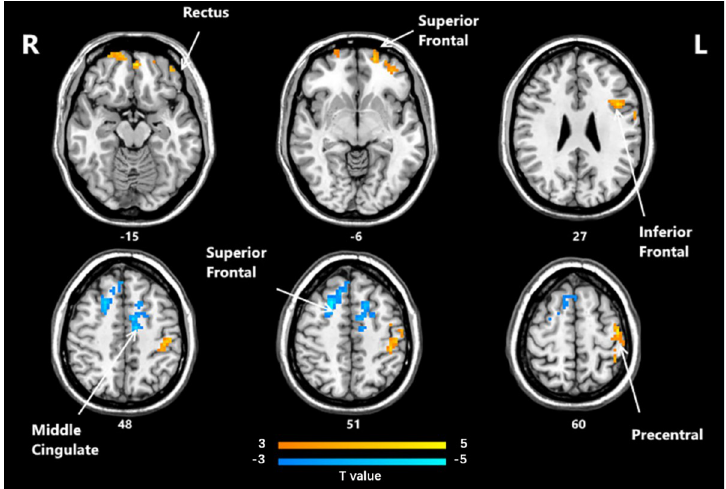
Fig 5. Brain regions that showed significant alterations in ReHo values between the two groups post-HD-tDCS and post-sham stimulation (P < 0.05, AlphaSim corrected). The yellow color denotes HD-tDCS > sham stimulation in the ReHo values and the blue color denotes HD-tDCS < sham stimulation. The T-value bars are shown at the bottom. Compared with HD-tDCS and sham stimulation, the areas with high ReHo values include Rectus L, Frontal Sup Orb L, Precentral L, Frontal Inf Oper L, areas with low ReHo values include Frontal Sup R and Cingulum Mid L. ReHo, regional homogeneity; HD-tDCS, high-definition transcranial direct current stimulation.